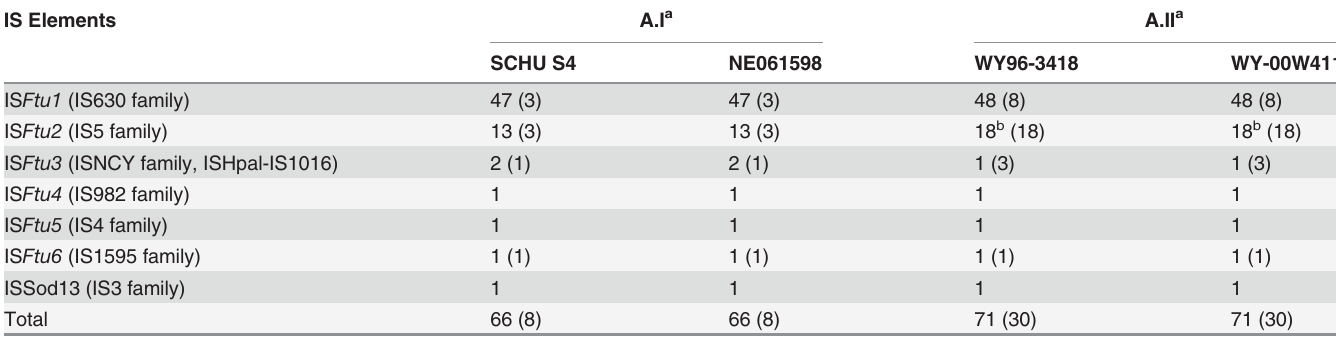
Table 4. Comparison of IS element content in F . tularensis A.I and A.II strains. IS